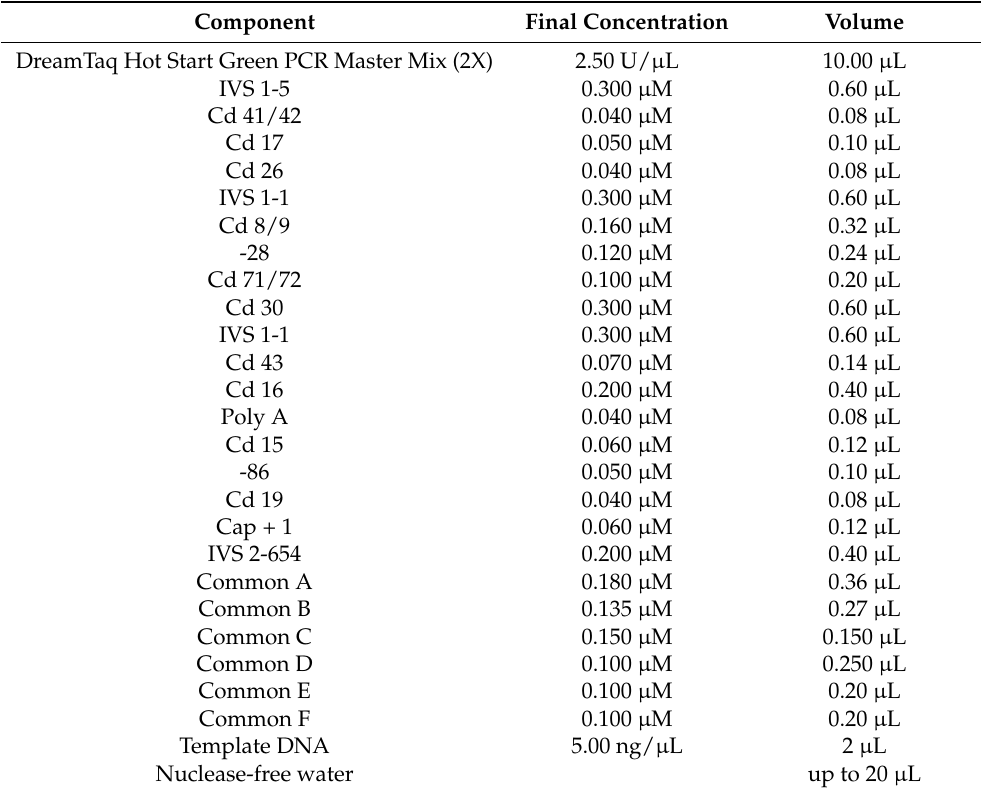
Table 2. Components of the PCR reaction mix analysis.